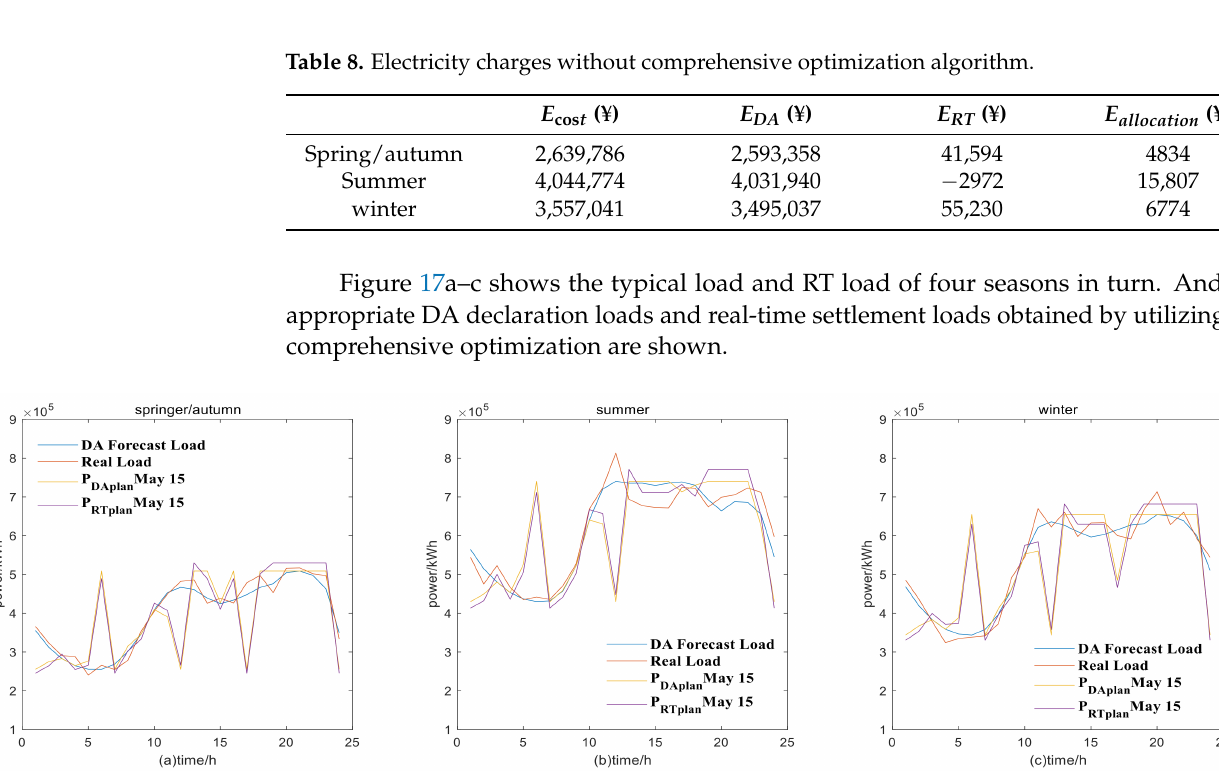
Figure 17. Typical load, RT load, DA load and RT settlement load during the four seasons. Figure reference: P rep refers to